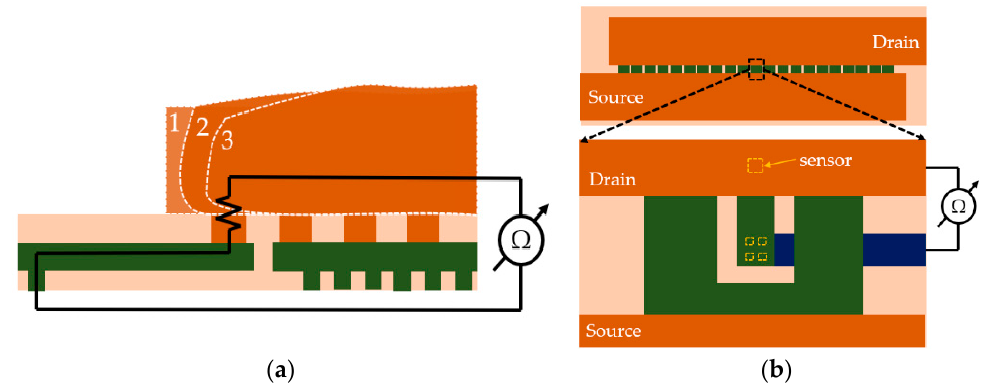
Figure 6. Delamination sensor: ( a ) working principle; ( b ) top view of the position on the chip and layout detail.